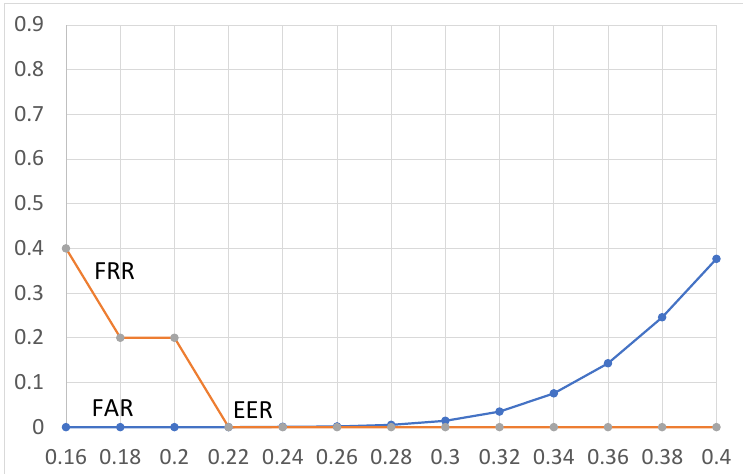
Figure 6. EER for MPEG-4 AAC manipulation. The x-axis represents the threshold (0–1), and the y-axis represents the error rate (0–100).